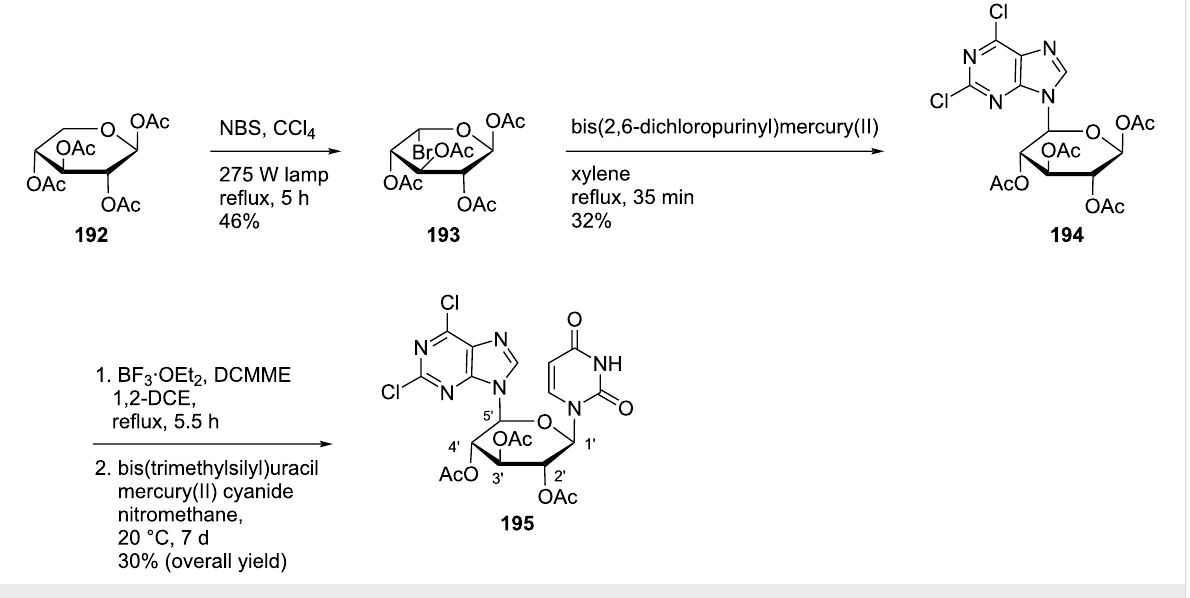
reaction with substituted thymine and uracil 198a , b afforded the benzylated double-headed nucleosides 199a – c . Next, debenzy- lation of the nucleoside monomers 199a–c afforded the final double-headed nucleoside monomers 200a–c . (Scheme 52)